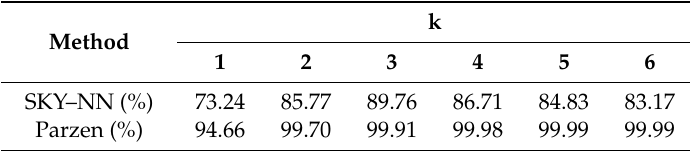
Table 6. Single skyline on the synthetic Dataset